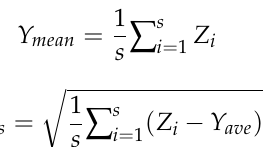
Figure 11. Elevation difference distributions of Samp53: ( a ) MIWSA; ( b ) random algorithm; ( c ) nor- mal algorithm; ( d ) voxel algorithm; ( e ) k-means algorithm; ( f ) curvature algorithm.